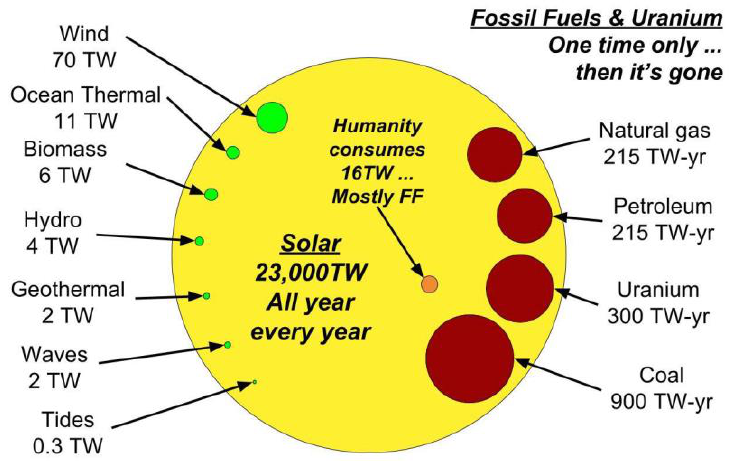
Figure 6. Fossil fuels and nuclear energy are transitory and deliver about 16 TW, only 0.05% of the energy on the planet [20].